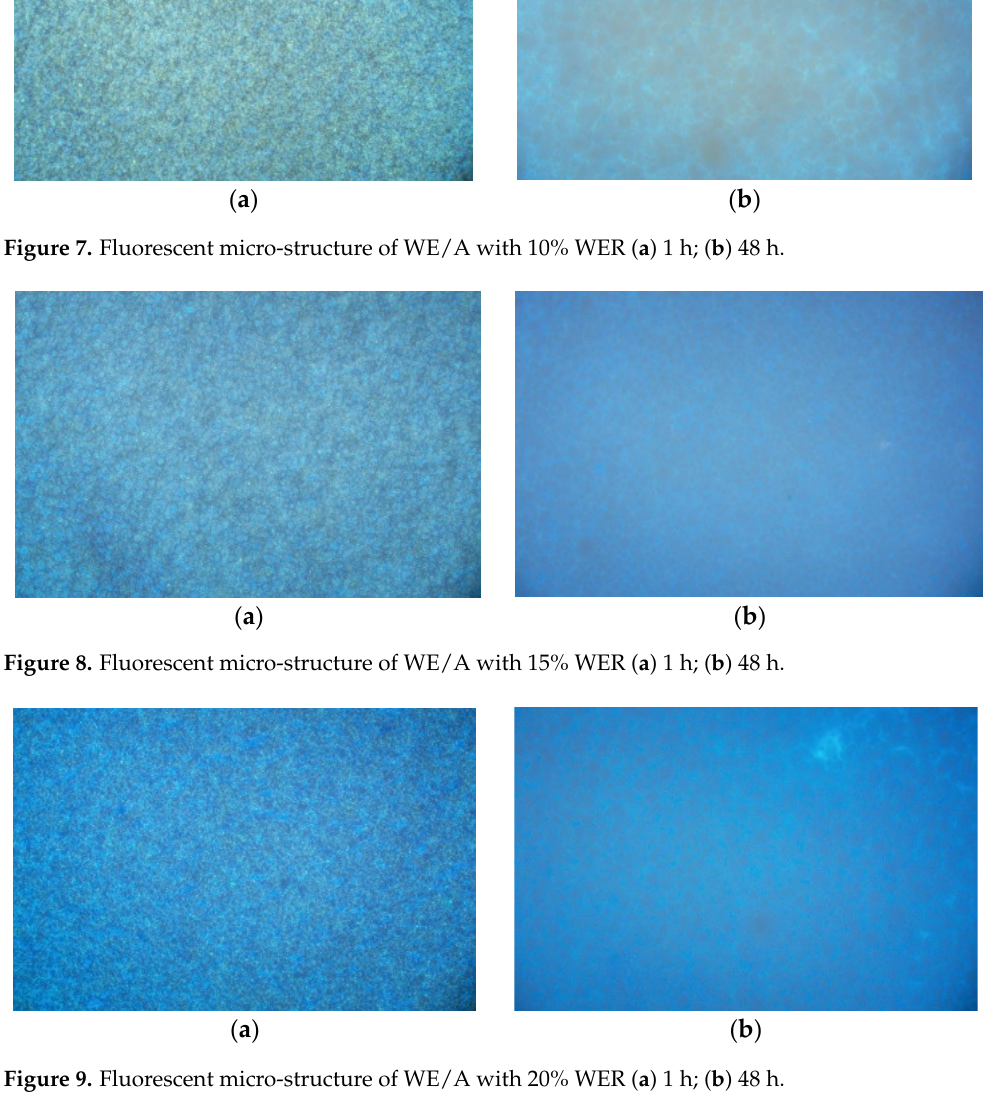
( a ) ( b ) Figure 10. Fluorescent micro-structure of WE/A with 25% WER ( a ) 1 h; ( b ) 48 h. ( a ) ( b ) Figure 11. Fluorescent micro-structure of WE/A with 30% WER ( a ) 1 h; ( b ) 48 h. ( a ) ( b ) Figure 12. Fluorescent micro-structure of WE/A with 35% WER ( a ) 1 h; ( b ) 48 h.